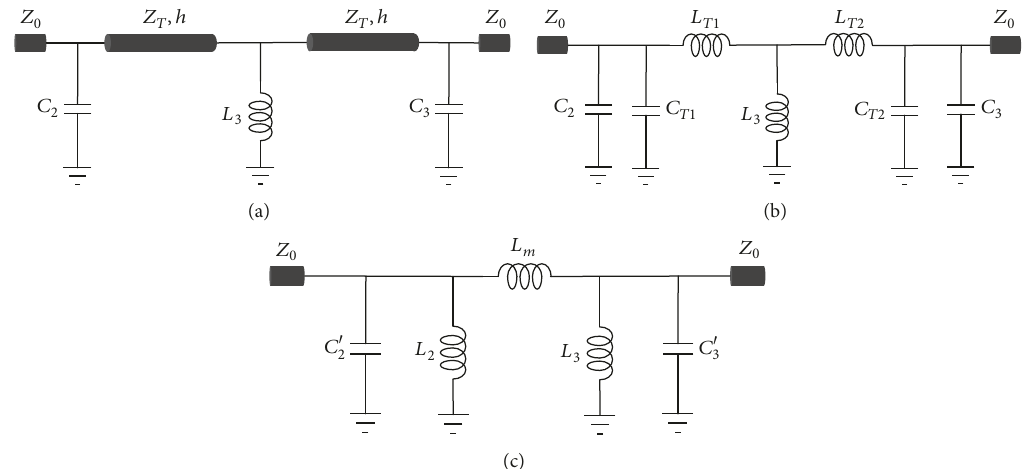
Figure 3: (a) The equivalent circuit model of high-frequency passband (b). The simplified circuit model of (a). (c) Simplified by converting the 𝑇 -network to 𝜋